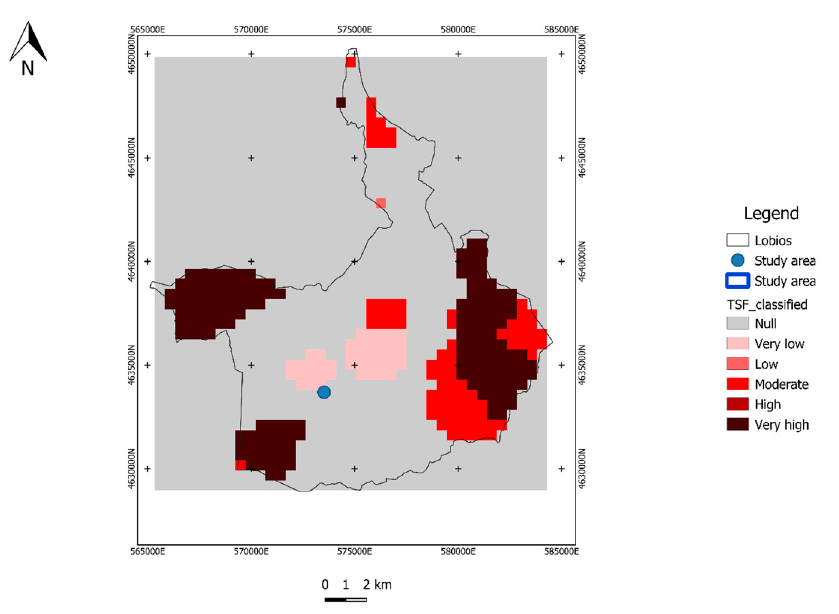
Figure 7. Map of the registered forest fires classified in the Lobios municipality. The map coordinate system is EPSG:25829 ETRS89/UTM zone 29N.